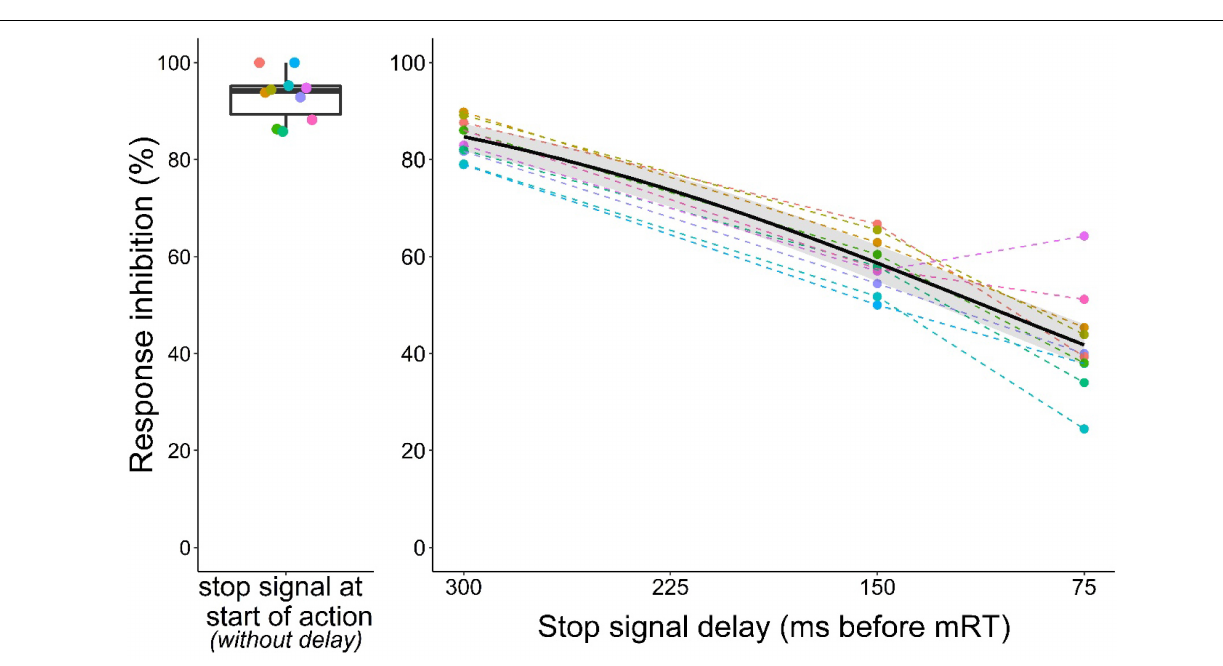
FIGURE 6 | Inhibition curve of mice in the stop signal task. The left panel shows baseline performance (i.e., no delay between trial initiation and stop signal, data from Figure 2C ). On the right panel stop signal delays are shown on a scale relative to each individual mean reaction time (mRT). Response inhibition became more difficult the further a mouse had already progressed toward making its second nose poke. Black curve represents the logistic model with 95% confidence interval in gray. Colors identify individuals. Data from n = 10